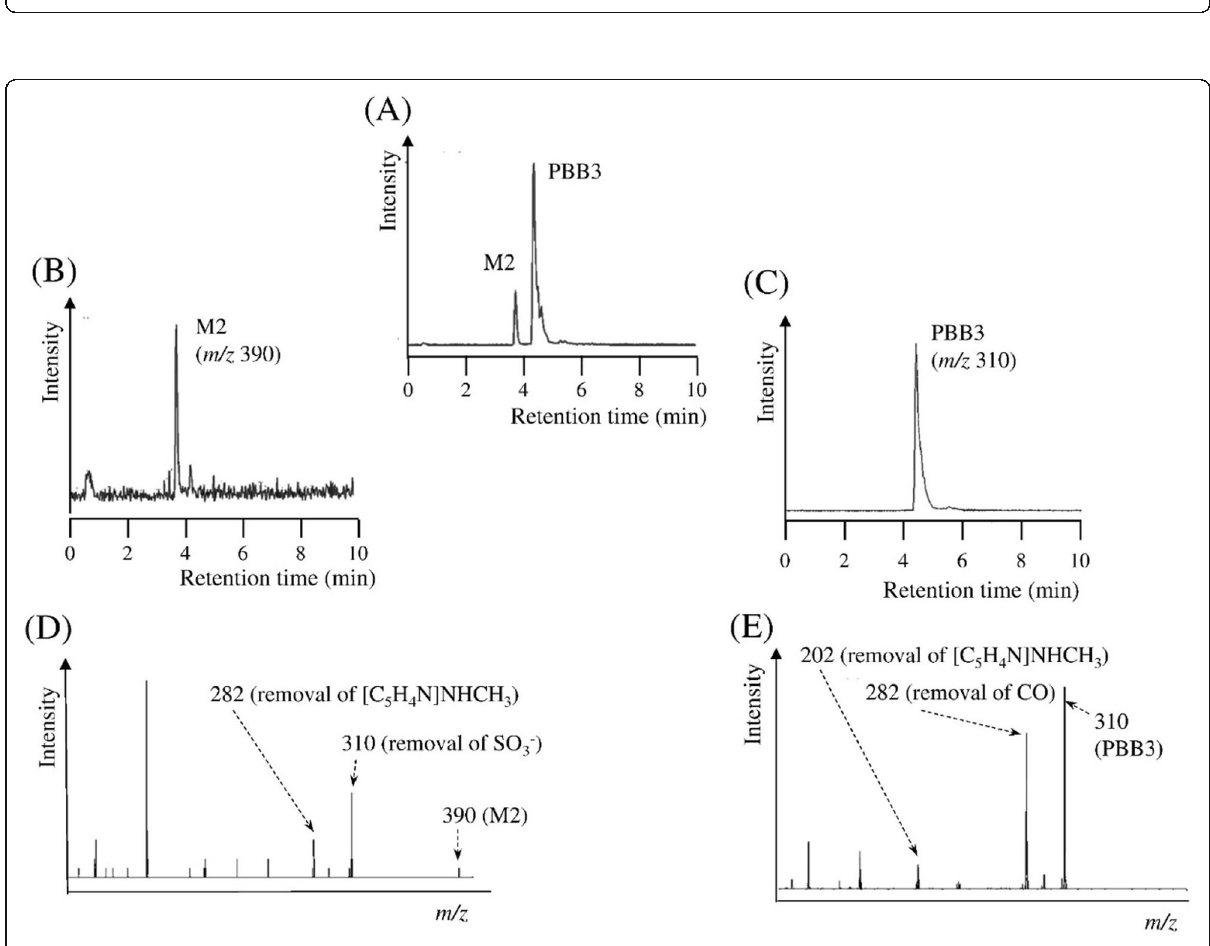
Fig. 2 Major metabolic pathways for [ 11 C]PBB3 and chemical structures of metabolites (SULT sulfotransferase). Adapted with permission from Ref. [48]